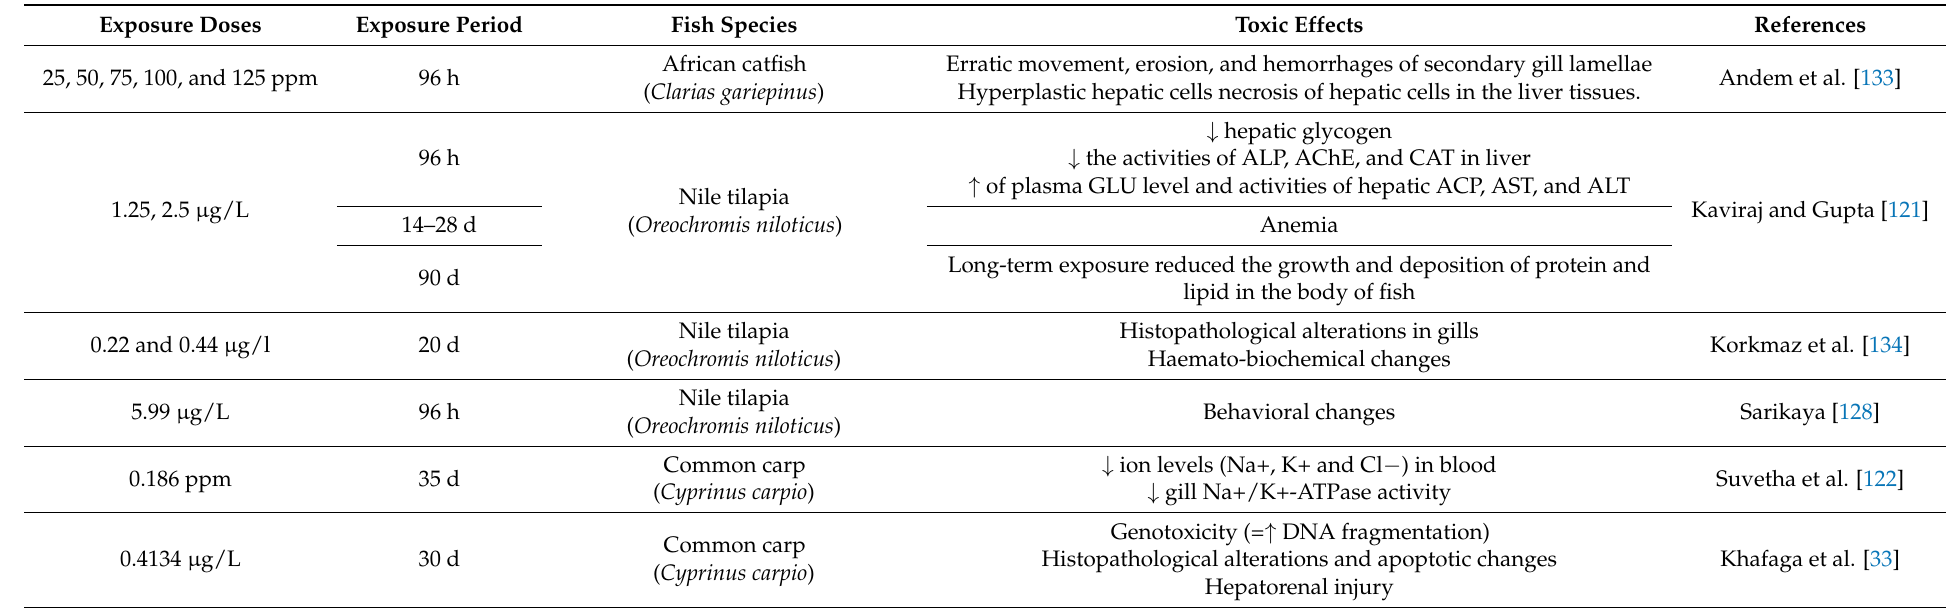
Table 2. Summary of the toxic effects of Cypermethrin (CYP) in several fish